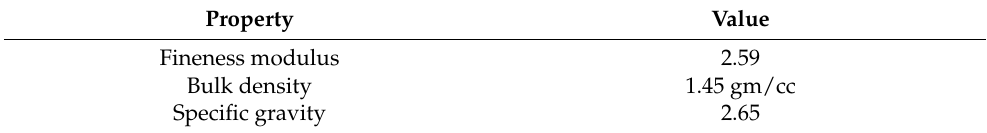
Table 3. Fine aggregate physical properties.